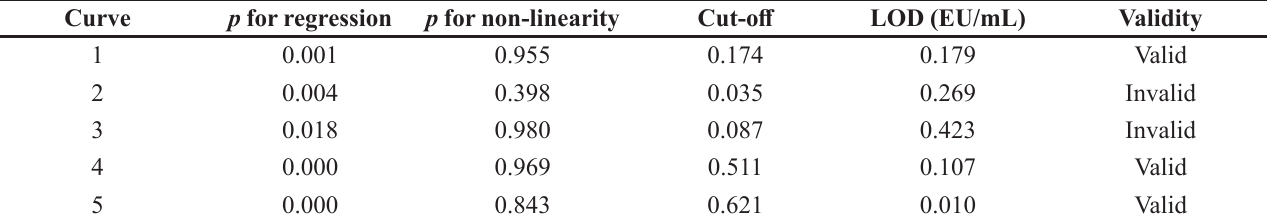
TABLE I - Regression and non-linearity p values calculated for endotoxin standard curves as validity criteria. Cut-off and Limit of detection (LOD) calculated for each test Curve